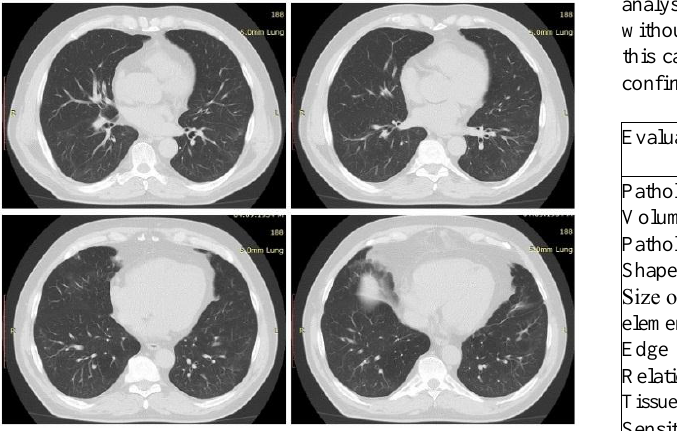
Figure 13 . CT images of the 2 nd patient, follow-up after 6 months.